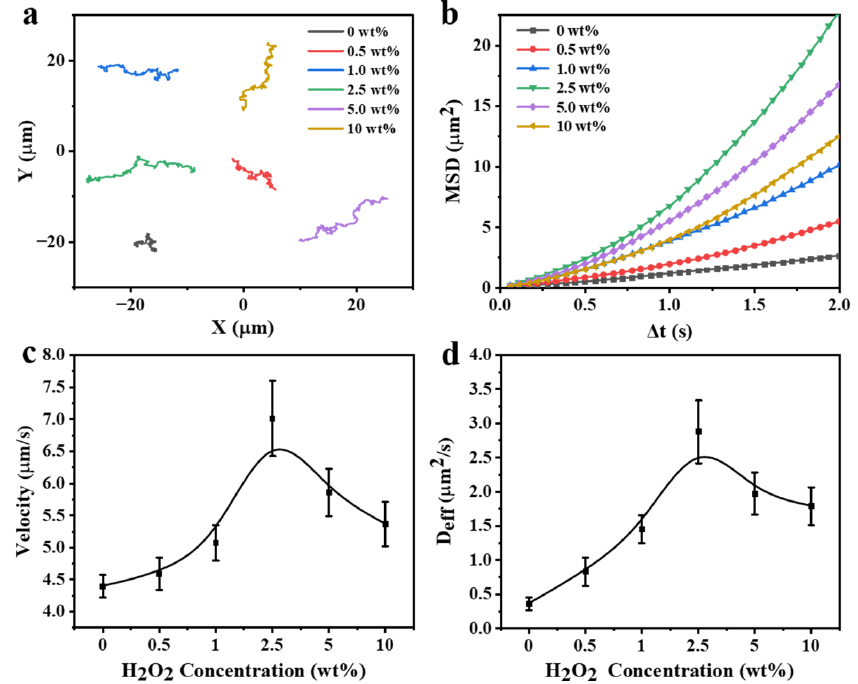
Figure 5. Motion analysis of the FCNMs at different H 2 O 2 concentrations. ( a ) Track trajectories of the autonomous motion of the FCNMs in 10 s. ( b ) MSD curves versus Δ t , ( c ) corresponding average velocities, and ( d ) average diffusion coefficients at different H 2 O 2 concentrations.